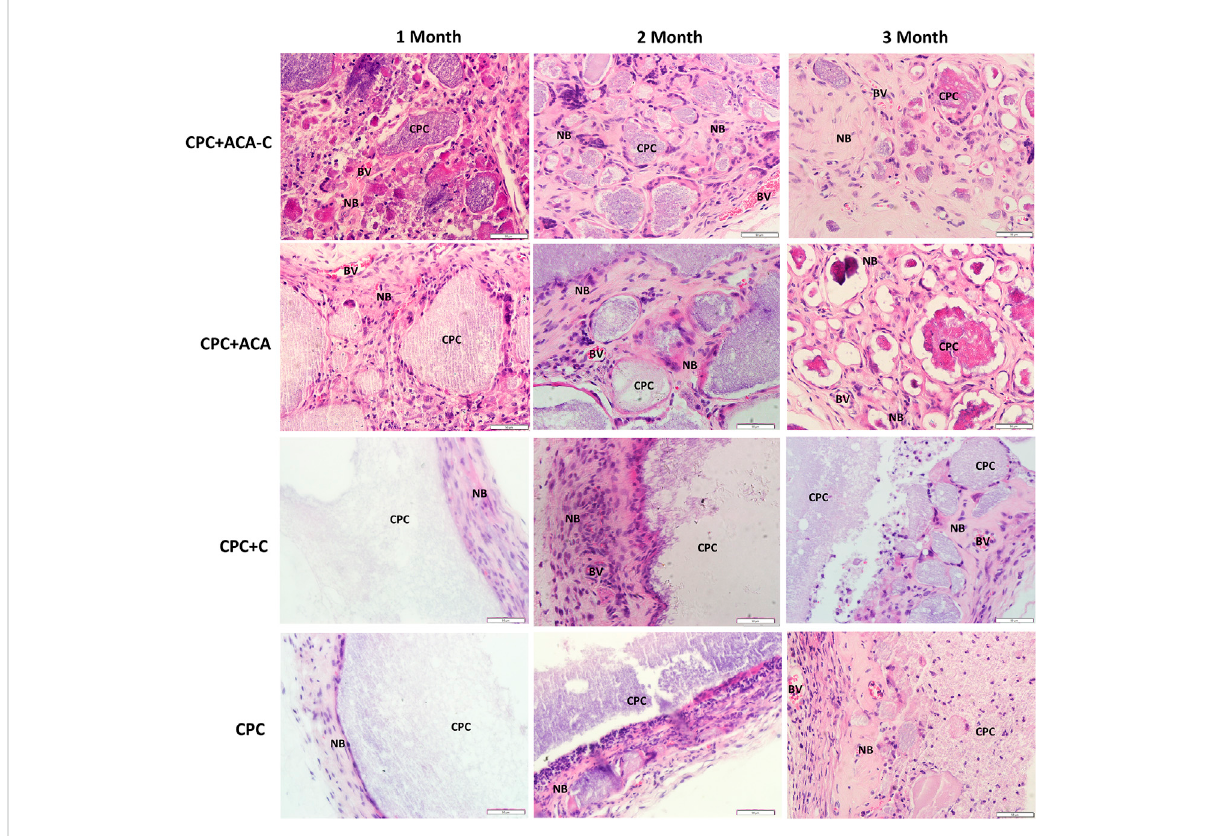
FIGURE 6 H&E-stained tissue sections of the CPC + ACA-C, CPC + ACA, CPC + C and CPC groups after 1, 2 and 3 months of implantation (NB: newly formed bone; CPC: implanted samples; BV: blood vessel; bar = 50 μ